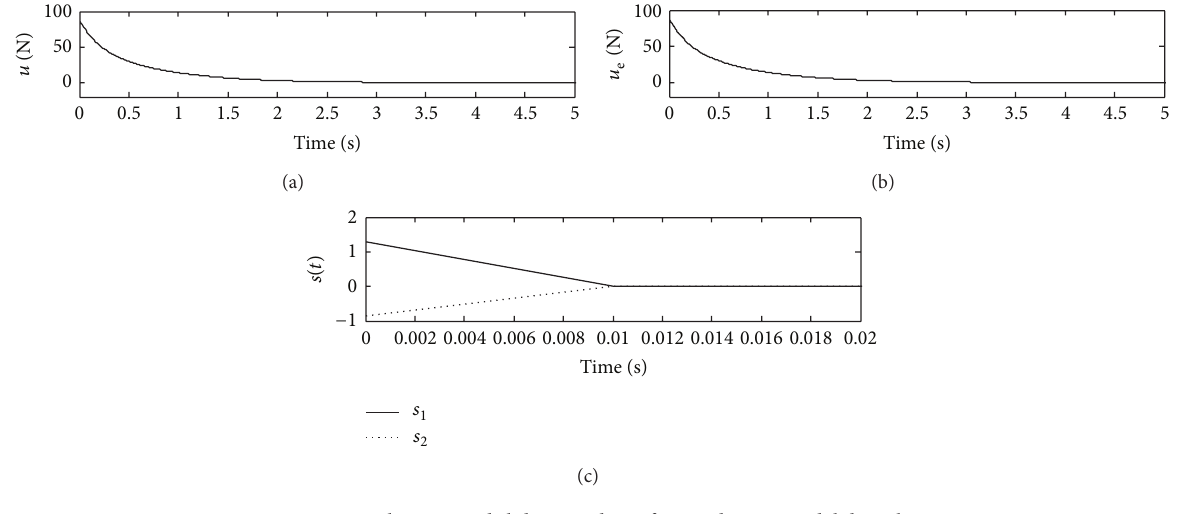
Figure 2: Control inputs and sliding mode surface under sinusoidal disturbance.